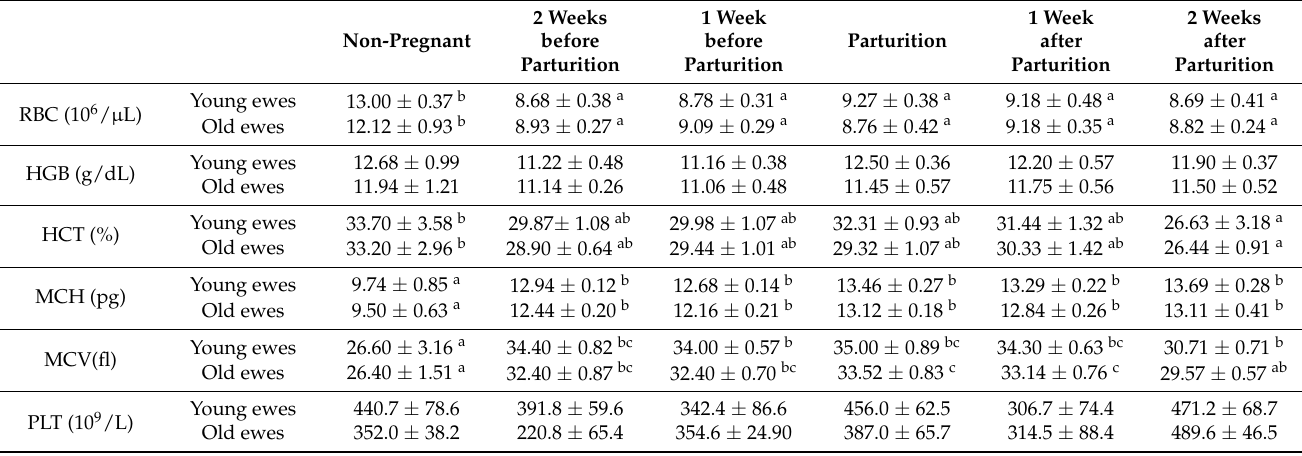
Table 2. Red blood cell parameters in the blood plasma of ewes ( n = 18). Non-Pregnant